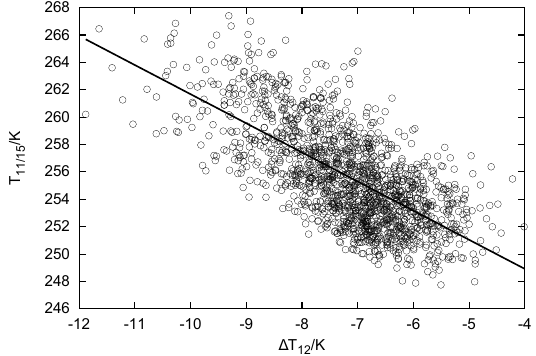
Figure 5. Scatter plot showing a linear correlation for the differ- ence between channel 12 brightness temperatures (NOAA 15 mi- nus NOAA 14) and the NOAA 15 channel 11 brightness temper- ature computed using the Lindenberg profiles. The linear Pearson correlation coefficient is − 0 .